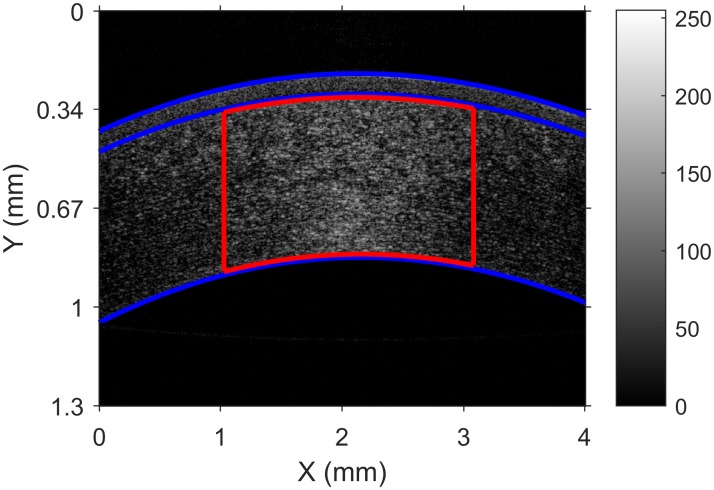
An example of a cropped corneal OCT image and the ROI demarked by the red lines.Blue lines indicate from the top the epithelium, Bowman’s layer and endothelium.